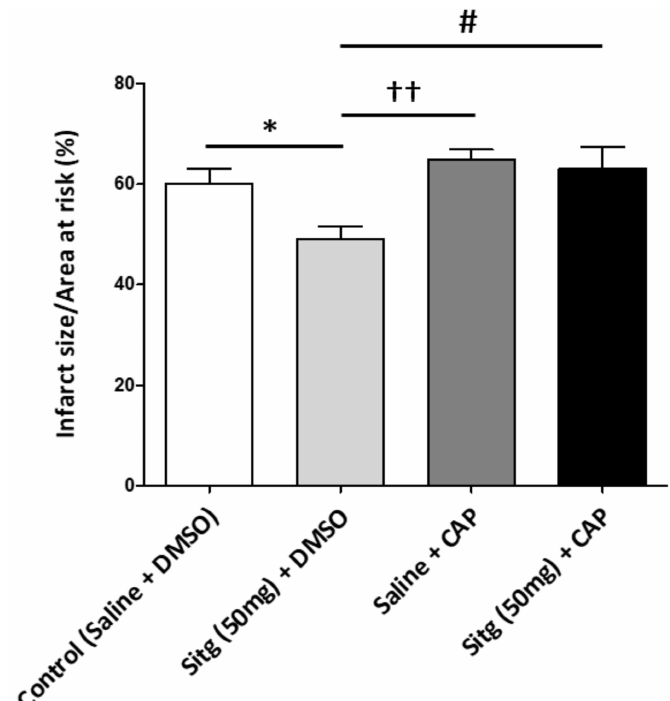
Figure 10. Loss of cardioprotective effect mediated by TRPV-1 and increase in infarct size with intraperitoneal injection of TRPV-1-inhibitor (Capsazepine), Infarct size expressed in (%). Comparing the 2 groups, Control (Saline) + DMSO (Control (Saline) + Dimethyl sulfoxide (i.p), n = 7) and Sitg (50 mg) + DMSO (Sitagliptin 50 mg + Dimethyl sulfoxide (i.p), n = 6), shows a significant decrease